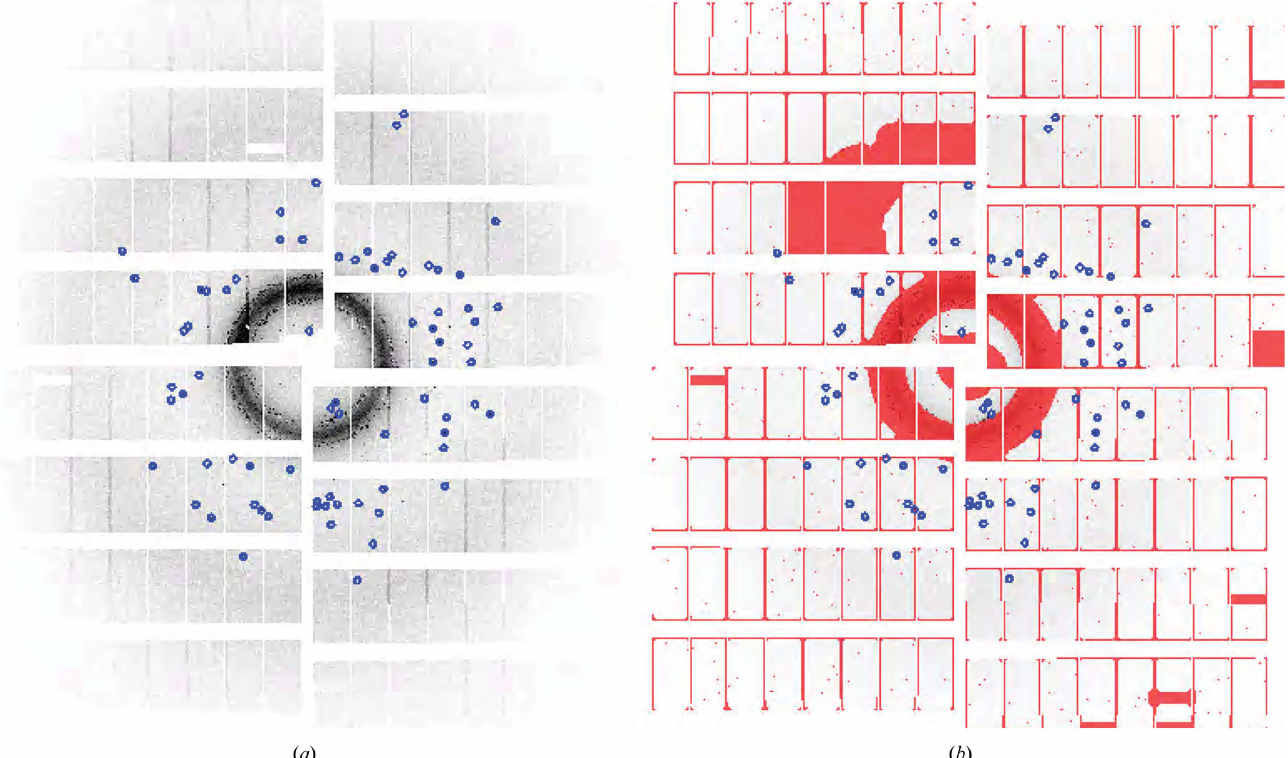
Figure 11 ( a ) Example of a diffraction pattern collected by the AGIPD. In ( b ) a mask (in red) is superposed that covers the strong rings at low resolution and inactive detector